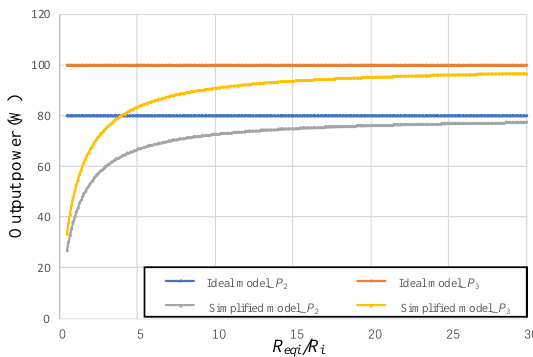
Figure 10. Experimental waveform: ( a ) transmitter coil; ( b ) receiver coils.